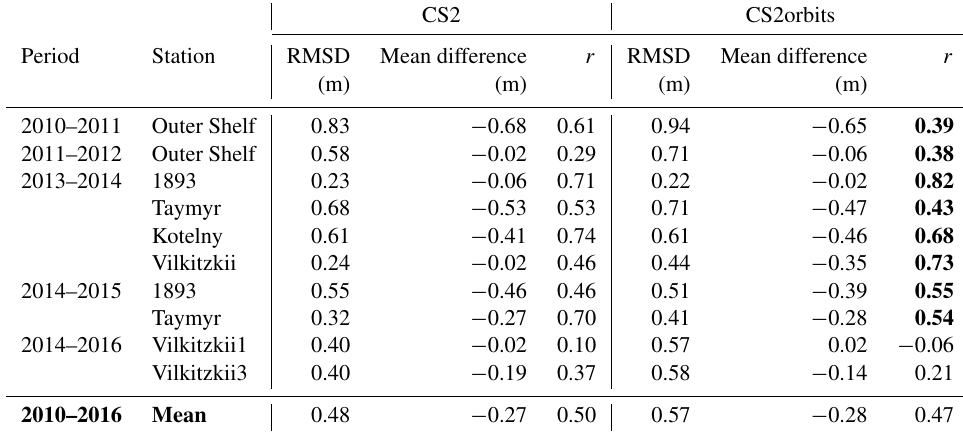
Table 2. Statistics of the comparison of gridded monthly mean CS2 and CS2orbit draft data with VAL mean sea ice draft for the period from 2010 to 2016. RMSD and mean difference were calculated for the differences of CS2 minus VAL mean sea ice draft. The Pearson correlation coefficient, r , was calculated for each station. Bold correlation coefficient values indicate significant correlation at the 95% confidence level. The bottom row of values show the averages of RMSD, mean difference and correlation coefficient over all stations. CS2 CS2orbits Period Station RMSD Mean difference r RMSD Mean difference